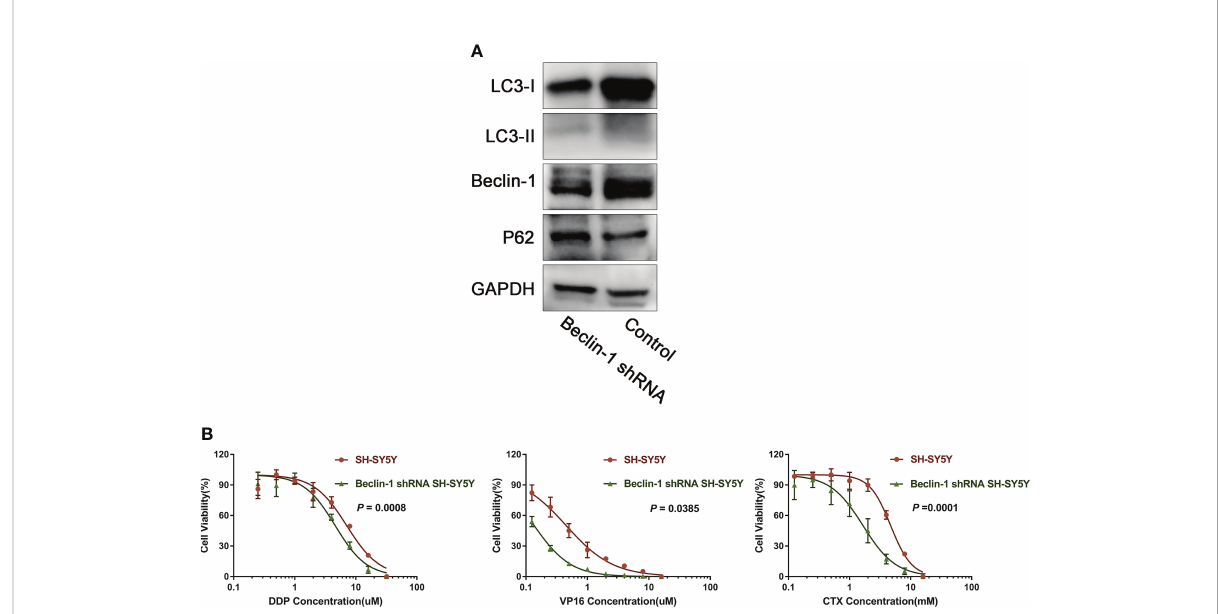
FIGURE 5 Down-regulation of Beclin-1 reverses chemoresistance of NB. (A) After transfection of Beclin-1 shRNA into SH-SY5Y cells, the expression of LC3-I and LC3-II decreased, while the expression of P62 increased. (B) After down-regulation of beclin-1 expression, IC50 of DDP, VP16 and CTX cells decreased compared with normal SH-SY5Y cells, The data represent the mean ± SEM of three independent experiments. P < 0.05, two-tailed t